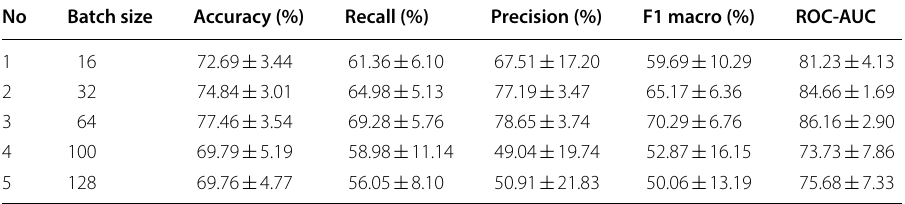
Table 7 Result of argument analysis using hierarchical attention network (Word Embedding from Scratch)